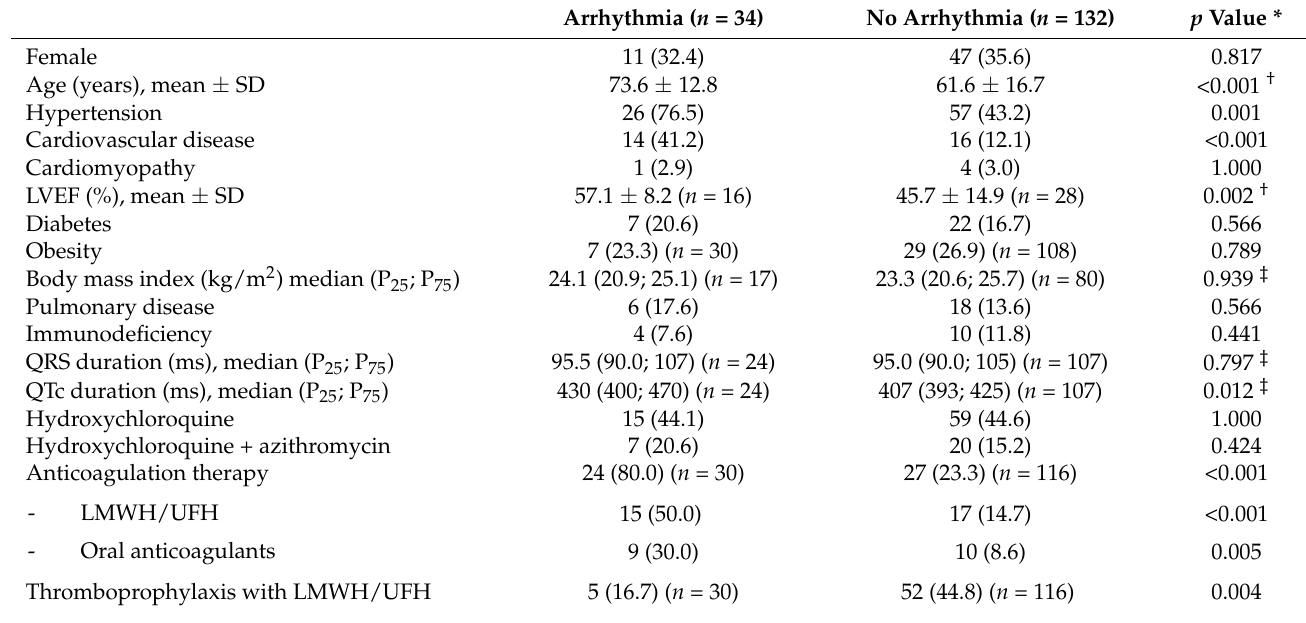
Figure 2. Arrhythmia diagnoses during hospitalization for COVID ‐ 19. ( A ) Distribution of arrhythmia types in all patients with arrhythmia during hospitalization. ( B ) Newly ‐ diagnosed arrhythmia types during hospitalization. ( C ) Newly ‐ diagnosed arrhythmia types in the subgroup of patients without any previous history of arrhythmia. Numbers depicted in the diagram reflect number and proportion of arrhythmia diagnoses. As one patient may have had multiple arrhythmia types, this number does not correspond to group size of patients. AF = atrial fibrillation; PVC = premature ventricular complexes; SVT = supraventricular tachycardia; VF = ventricular fibrillation; VT = ventricular tachycardia. Table 1. Comparison of baseline